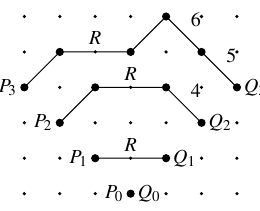
Figure 2: A 3-collection σ with the associated weights of W 0 marked on (neglecting the trivial weights on the ascending steps). Thus W 0 ( σ , R ) = 120 R 3 . Subtracting two from each marked numerical weight gives W 2 ( σ , R ) = 2 × 3 × 4 × R 3 = 24 R 3